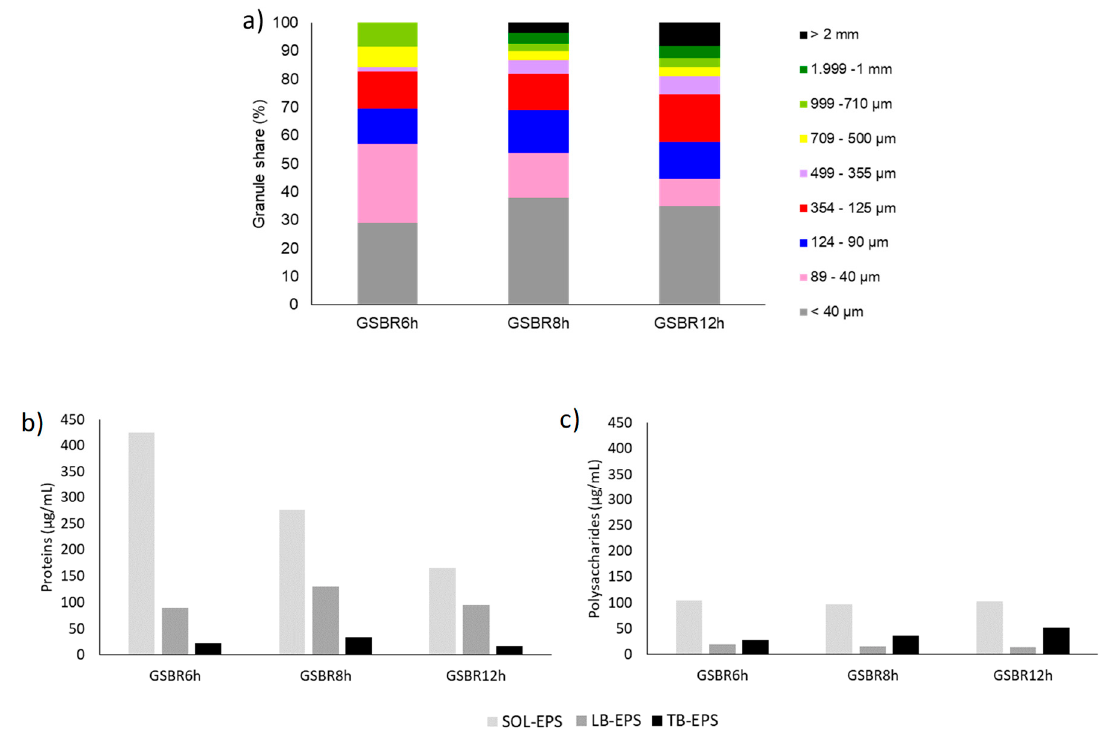
Figure 4. Granule diameters ( a ), and concentrations of proteins ( b ), and polysaccharides ( c ) in extracellular polymeric substances (EPS) depending on the length of the GSBR cycle.